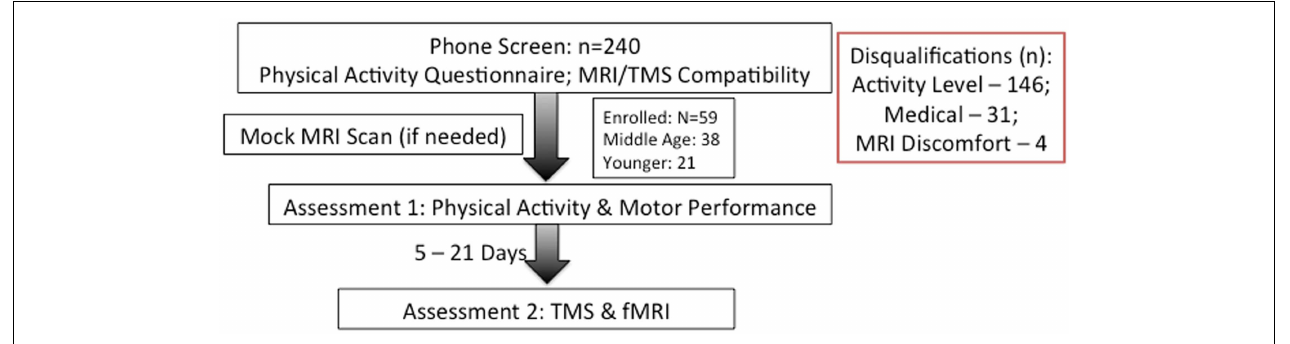
FIGURE 1 | Flowchart of study . Category and number of screen-outs are listed on